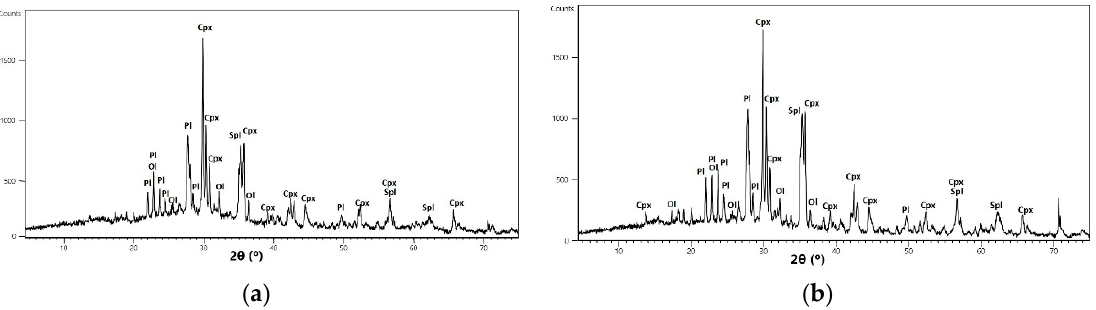
Figure 3. X-ray diffraction pattern of lapilli ( a ) (LP-FA) and lava-flow (MARIP) ( b ) samples. Mineral group abbreviations: Cpx = clinopyroxene, Ol = olivine, Pl = plagioclase, and Spl = spinel.